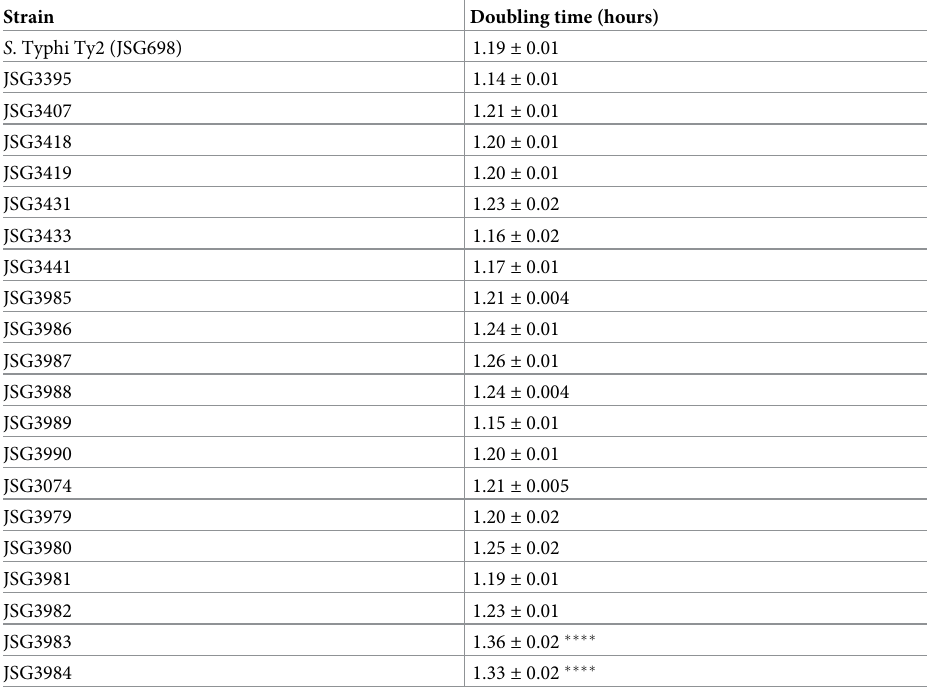
Table 2. Doubling time in hours for each of the indicated S . Typhi